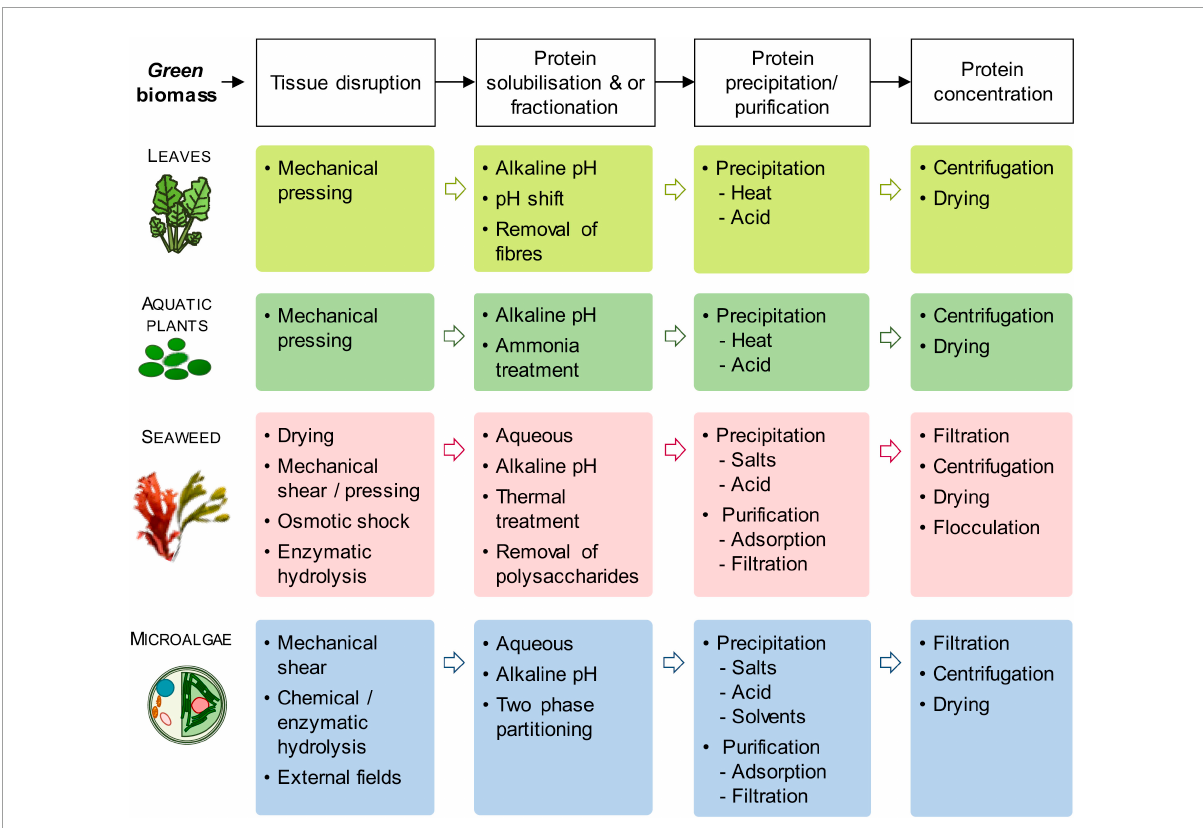
FIGURE1 Generic protein extraction process from green biomass (top line) and an overview of extraction methods for each biomass group. [Adopted from Tenorio et al. (83)] under Creative Commons CC-BY-NC-ND